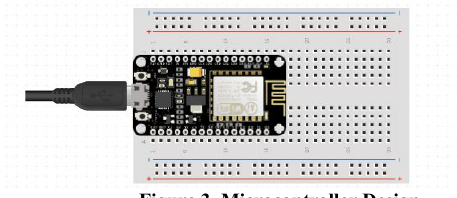
Figure 3. Microcontroller Design